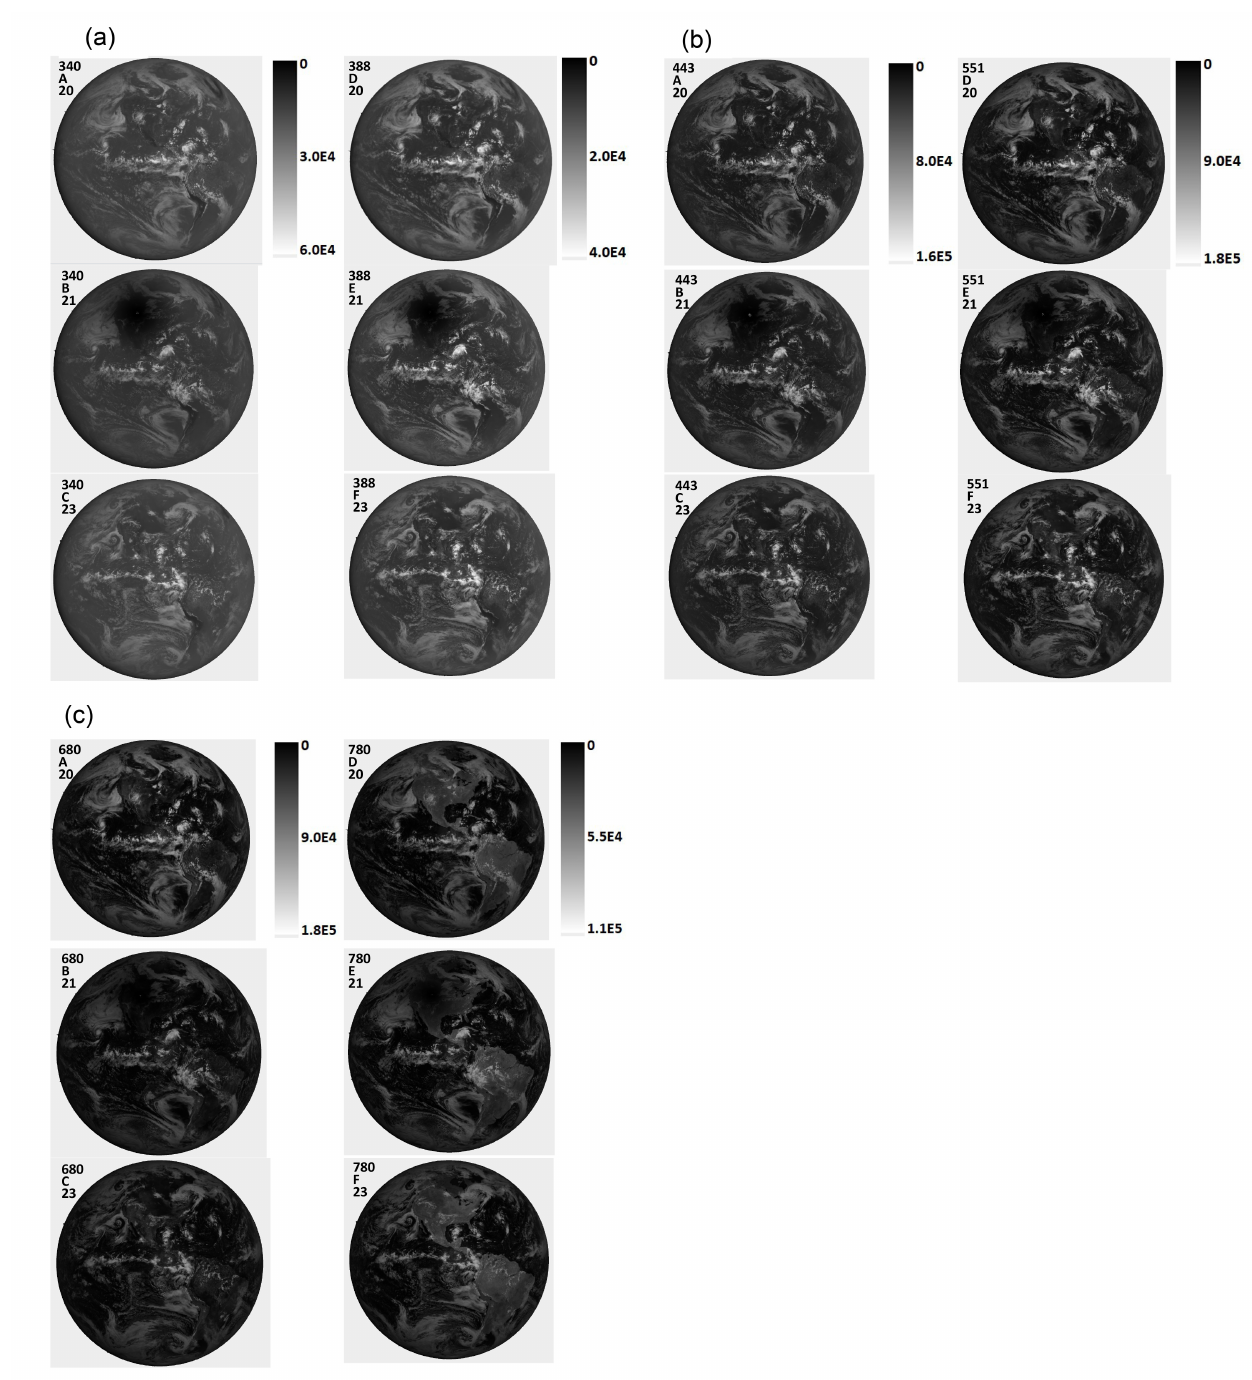
Figure 8. (a) Image in counts per second for 340 and 388nm for 20 August (A, D) , 21 August (B, E) , and 23 August (C, F) . The scale applies to the specific wavelength. North is up. (b) Image in counts per second for 443 and 551nm for 20 August (A, D) , 21 August (B, E) , and 23 August (C, F) . The scale applies to the specific wavelength. North is up. (c) Image in counts per second for 680 and 780nm for 20 August (A, D) , 21 August (B, E) , and 23 August (C, F) . The scale applies to the specific wavelength. North is